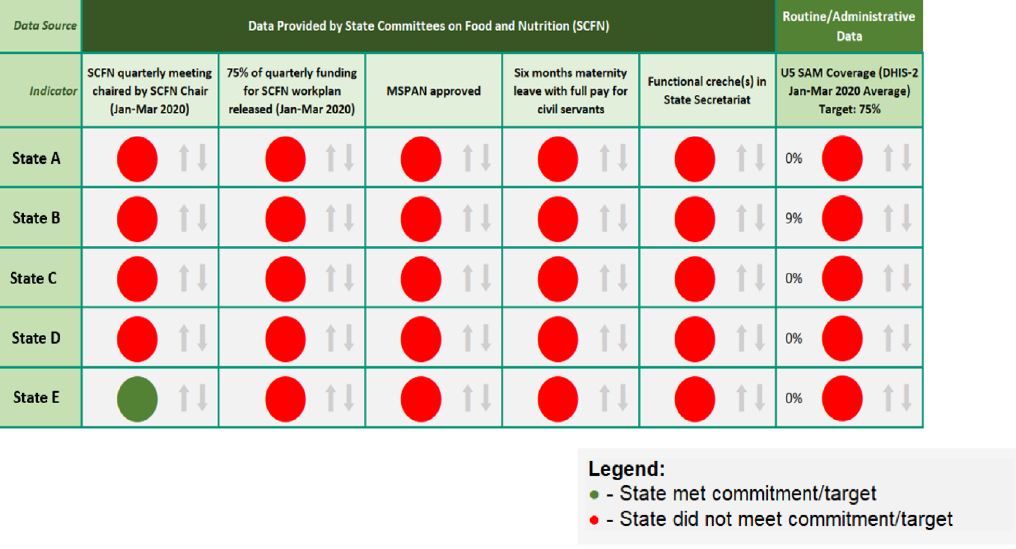
Figure 4. Final visualization format for the Nigeria Governors’ Forum nutrition scorecard. Green=State met commitment/target; Red=State did not meet commitment/target; MSPAN=multisectoral strategic plan of action on nutrition; DHIS-2=District Health Information System